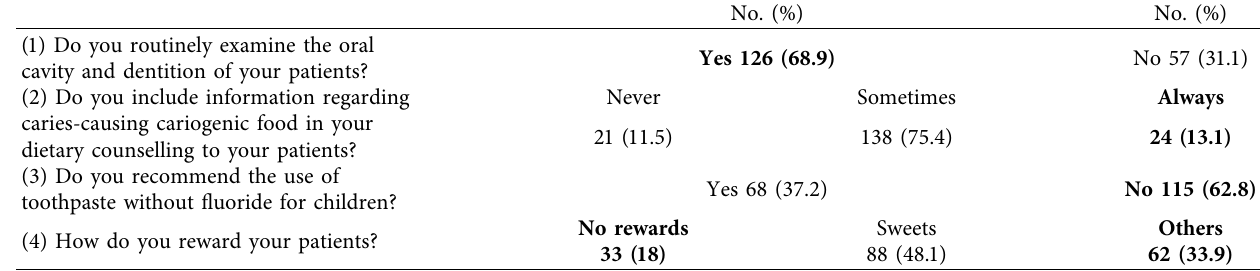
Table 4: Paediatricians’ behaviour questions.